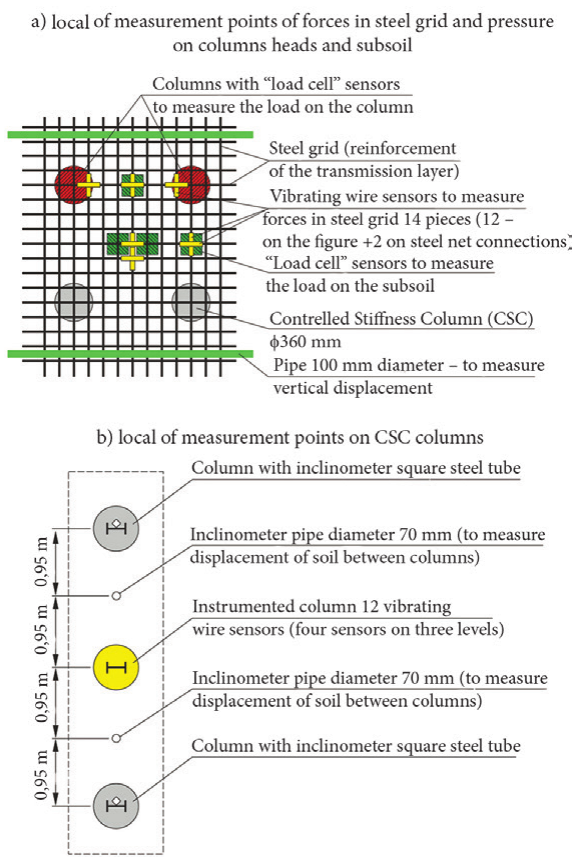
Fig. 3. Measurement details